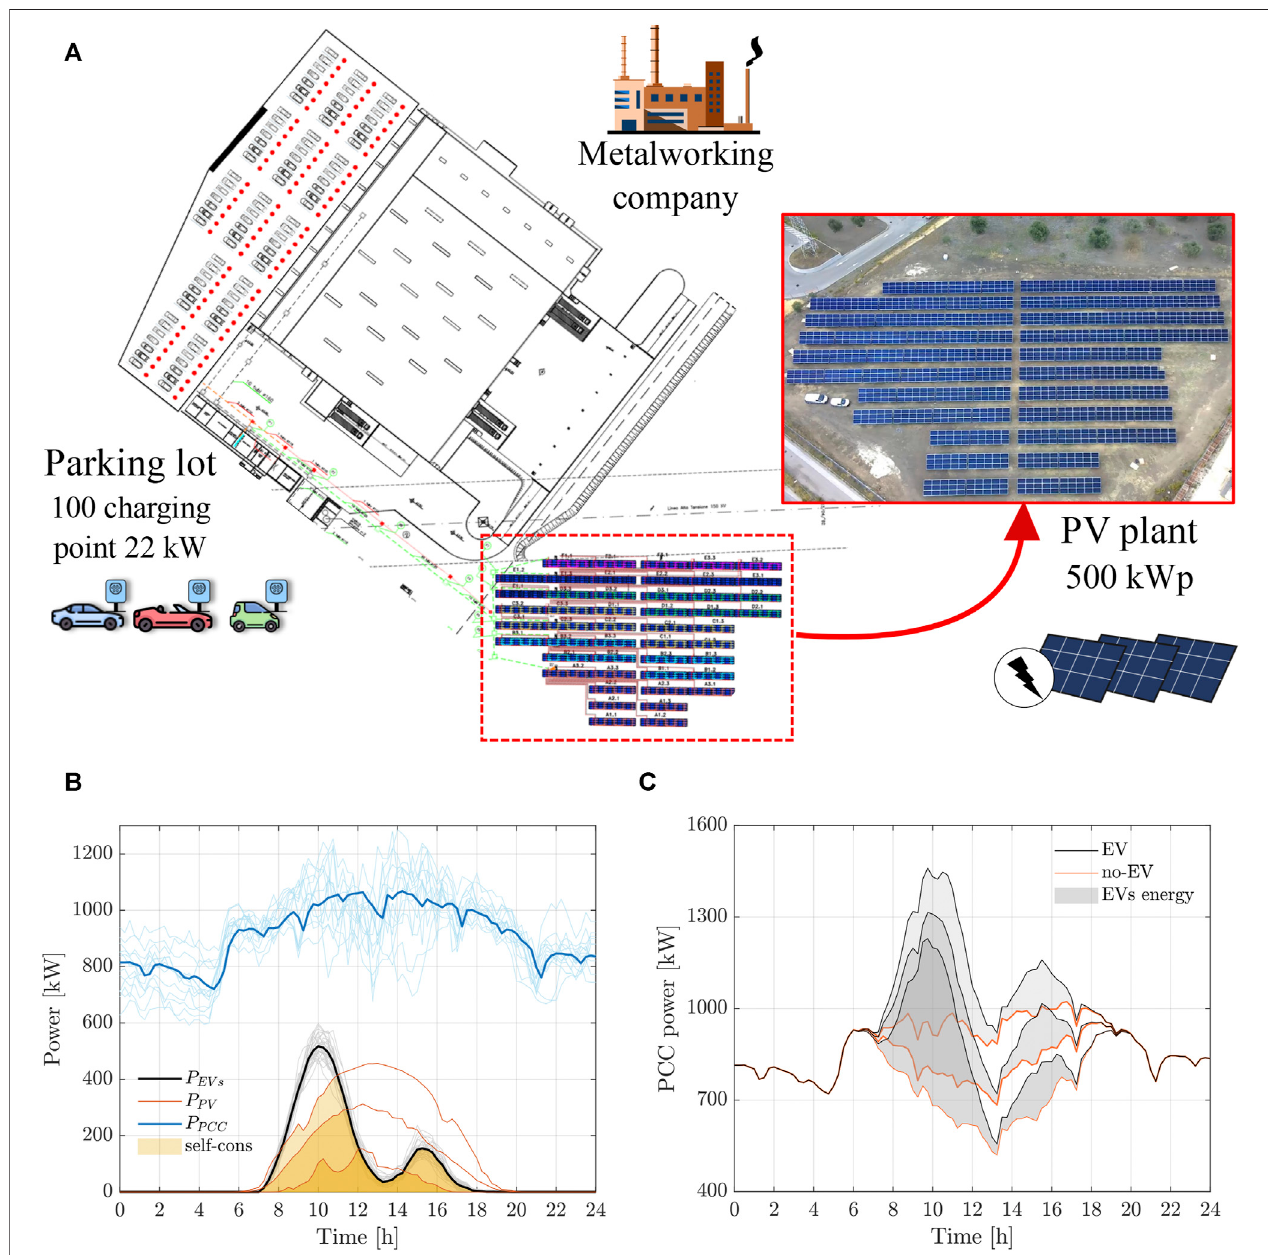
FIGURE 4 | (A) Industrial building reference scenario. (B) P L load pro fi les (light blue traces) together with the annual average (dark blue trace); 31-day aggregated EVchargingpower P EVs scenarios(graypro fi les)alongwiththeiraverage(blackpro fi le);PVgeneration P PV pro fi les(redlines)incaseoflow,medium,andhighirradiance. (C) Power P PCC exchanged with the grid (black pro fi les); aggregate EV energy request (gray areas); PCC power without considering EV charging (orange